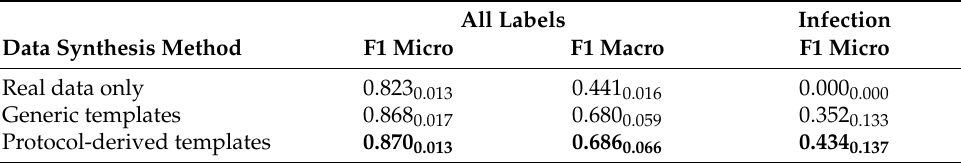
Table 8. Micro- and macro-averaged F1 results on our prospective test set as mean standard deviation of 10 runs with different random seeds. Bold indicates the best model for each metric.